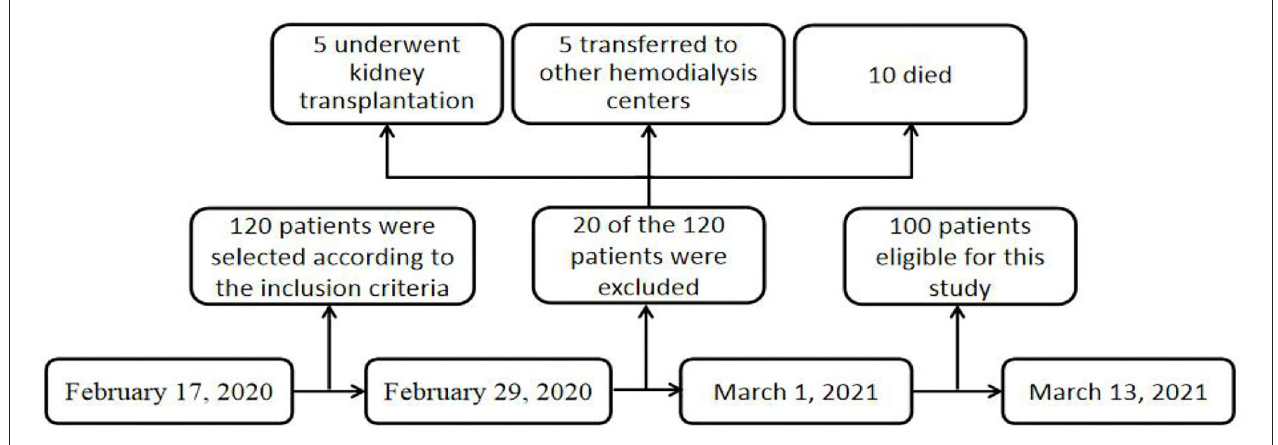
FIGURE 1 | A flow diagram of study design.